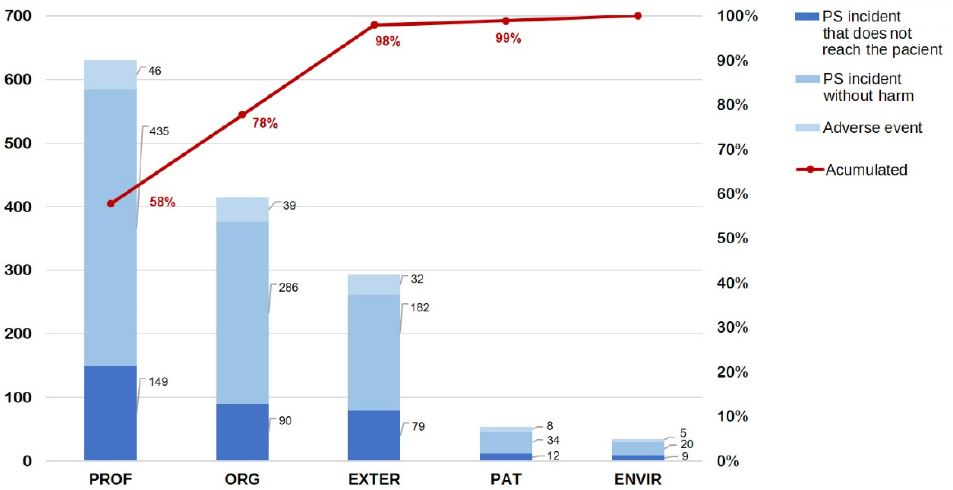
Figure 4. Pareto diagram of contributing factors frequencies in relation to the severity of the patient safety incident. The figure shows the contributing factors according to the WHO classification of the total patient safety incidents notified ( n = 1129) [7]. Each incident can have one or more contributing factors. PROF: professional, ORG: organisation; EXTER: external; PAT: patient; ENVIR: environ- ment.